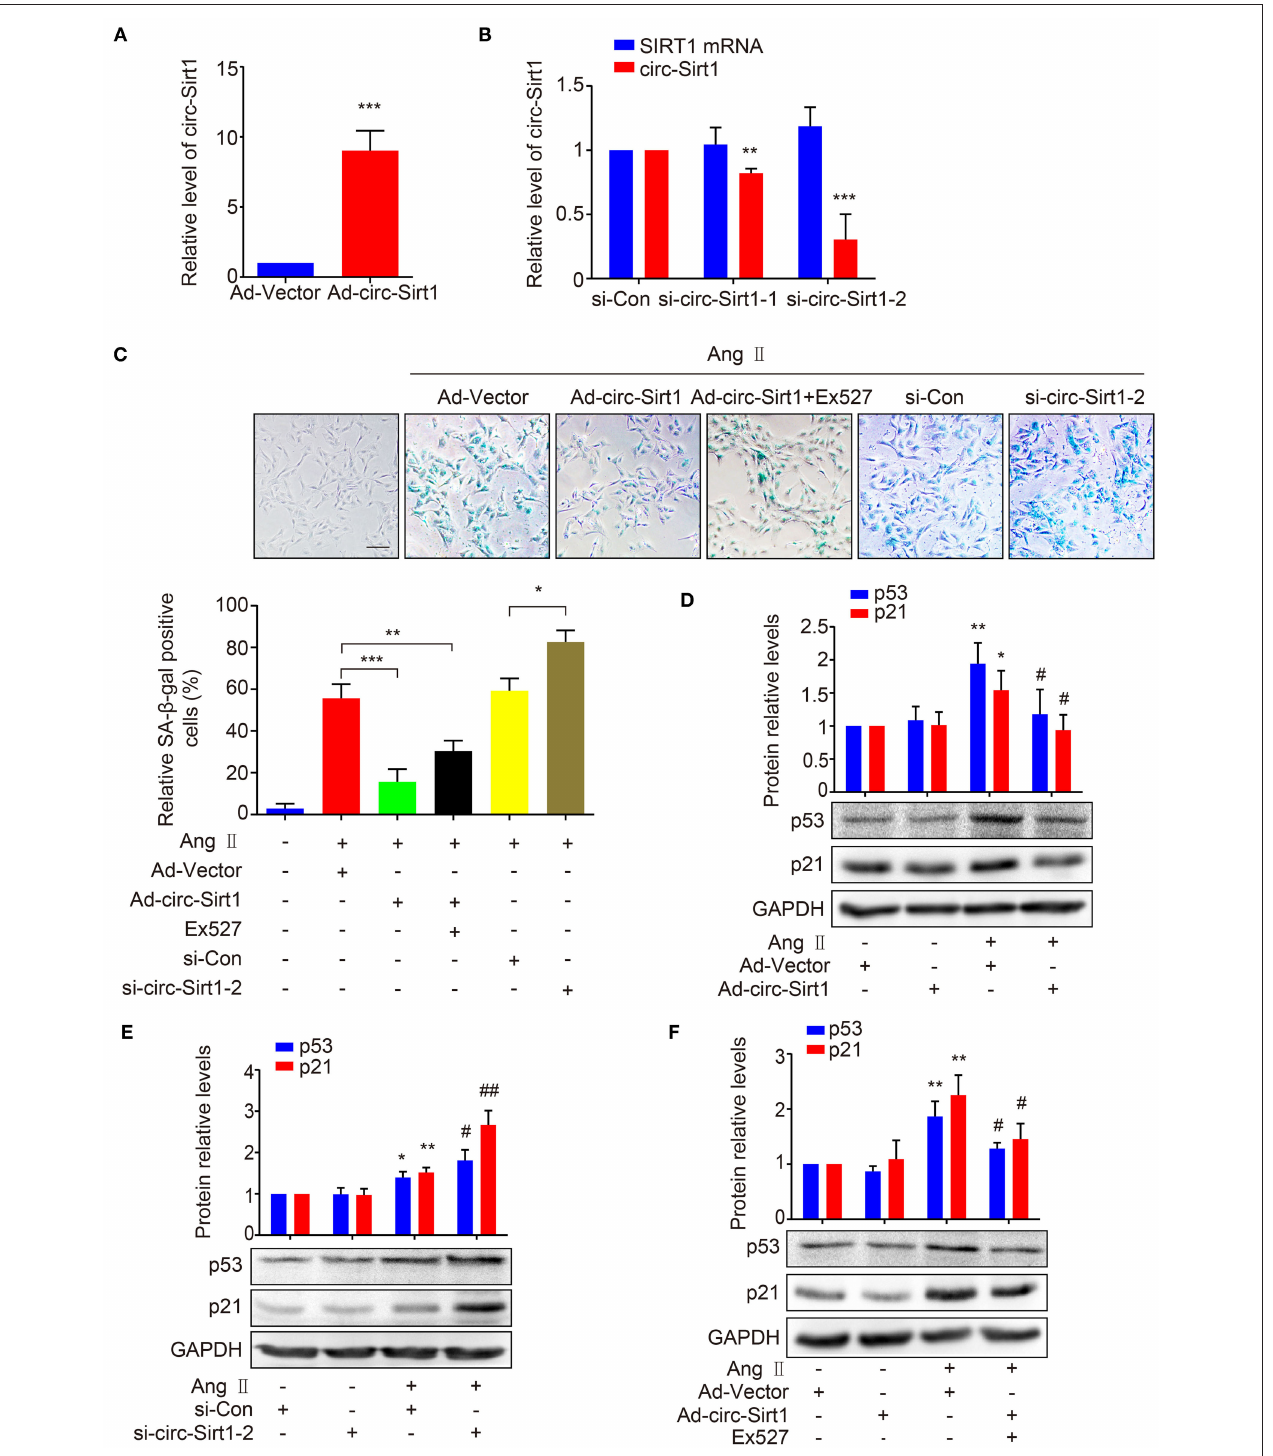
FIGURE 2 | circ-Sirt1 inhibits Ang II-induced senescence. (A,B) The expression of circ-Sirt1 increased in Ad-circ-Sirt1-infected VSMCs (A) , and decreased in VSMCs treated with si-circ-Sirt1 (B) . (C) VSMCs were infected with Ad-Vector or Ad-circ-Sirt1 and then treated with or without Ang II (100nM) for 5 days. For inhibition of SIRT1 activity, the cells were pretreated with Ex527 (20 µ M) for 4h before treated with Ang II. Representative senescence-associated β -galactosidase (SA- β -gal) staining. (D–F) Western blot for expression of p53 and p21. Bar graphs represent the mean ± SD and were analyzed with Student’s T -tests. * p < 0.05, ** p < 0.01, *** p < 0.001 vs. Ad-Vector + Ang II untreated group. # p < 0.05, ## p < 0.01 vs. Ad-Vector + Ang II group. n = 3/group for (A–F) .